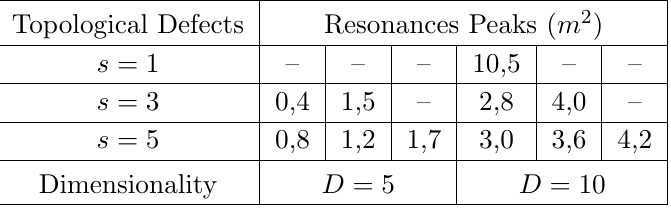
Table 3 . Peaks of resonances for massive left handed fermions.